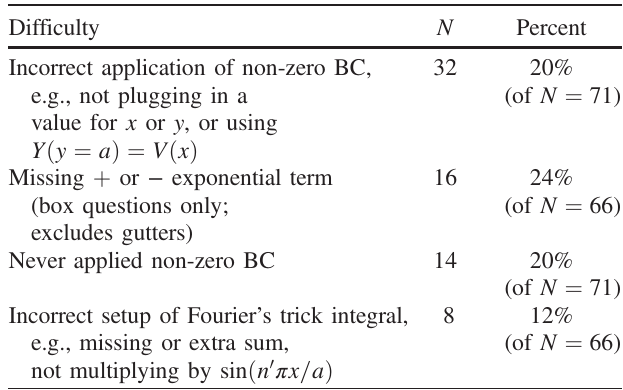
TABLE I. Difficulties setting up expressions that match the boundary conditions (BCs) in Cartesian. To account for the fact that certain difficulties were not applicable to all exam prompts, percentages are given with respect to the subset of incorrect solutions taken from the applicable semesters. Codes are not exhaustive or exclusive but represent the most common themes; thus, the total N in the table need not sum to